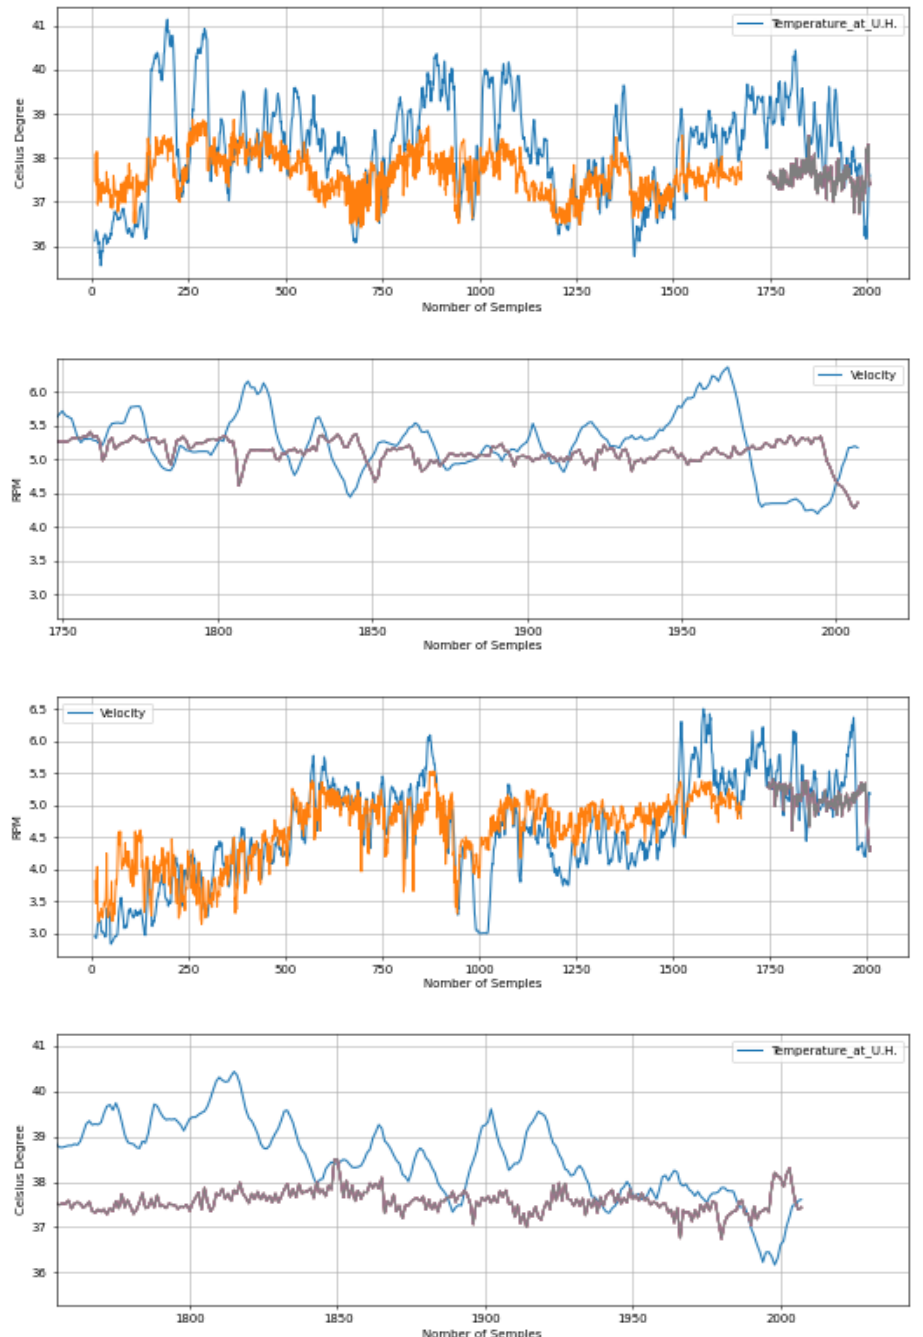
Figure 9. Variable forecast with a window of samples of 10 days, sampling rate two samples per day, and a network model with 50 units in the hidden layer. The blue lines show the actual value. The orange lines show the predictions during the training set and the gray lines show the predictions in the test